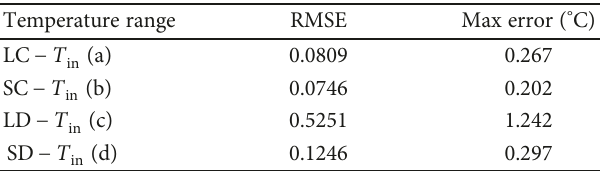
Figure 9: Validation results for T Table 6: Estimation errors for four validation data by combining the linear NN and